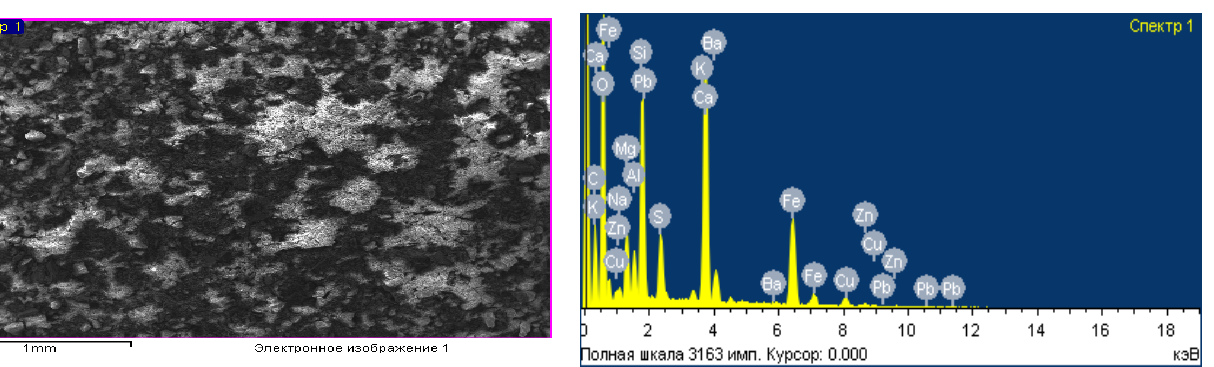
Figure 1. Micrography ( a ) and elemental analysis ( b ) of metallurgical waste.